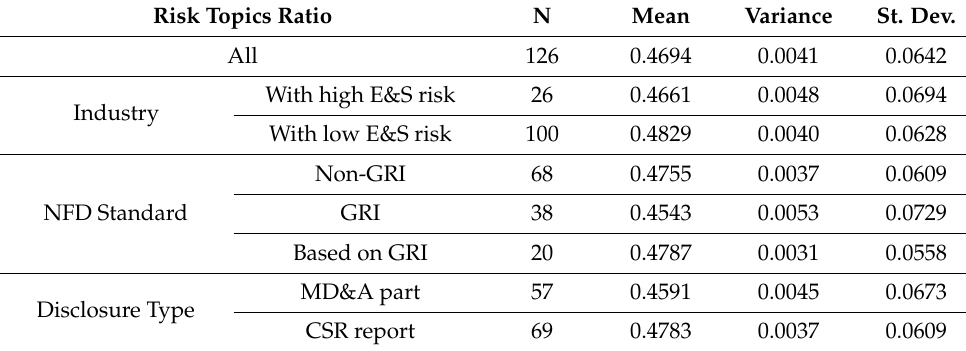
Table 4. Risk topics ratio descriptive statistics.